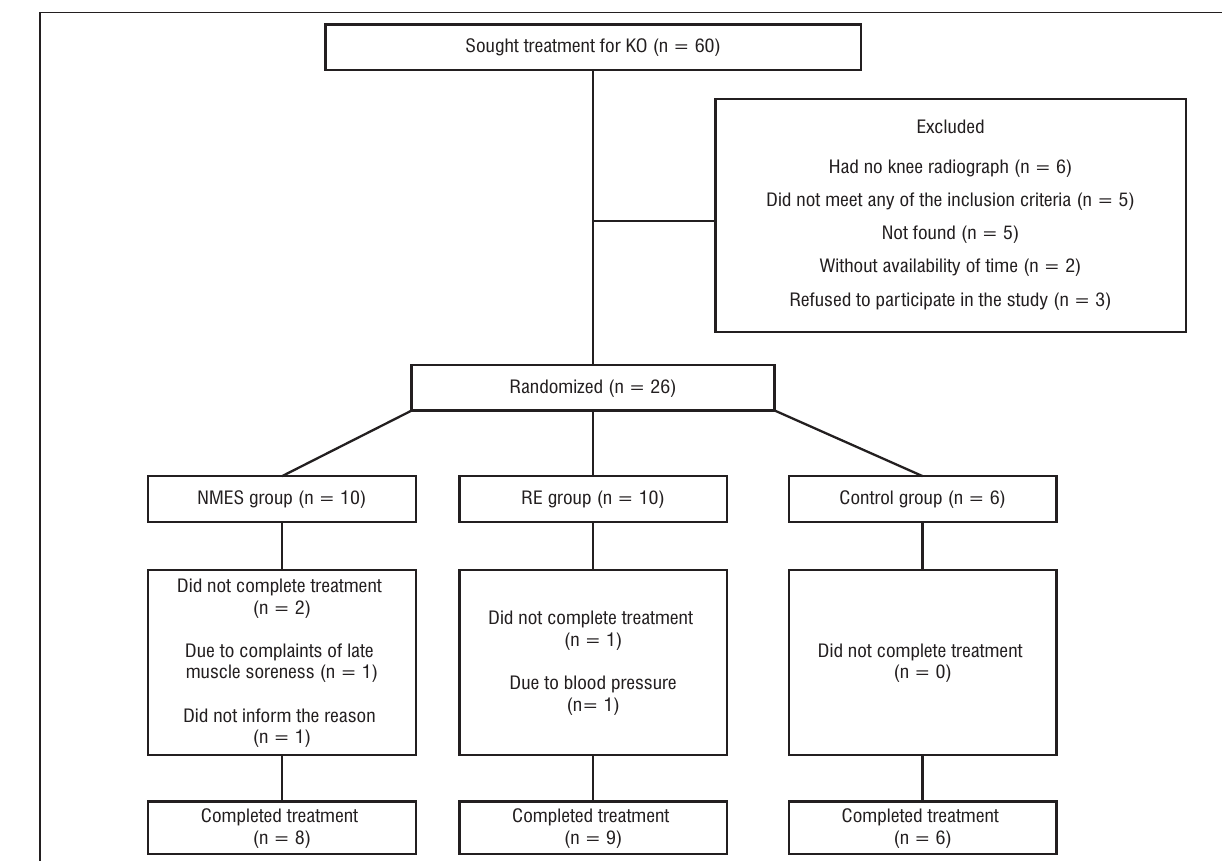
Figure 1 - Flowchart of patients’ inclusion in the study Source: Research